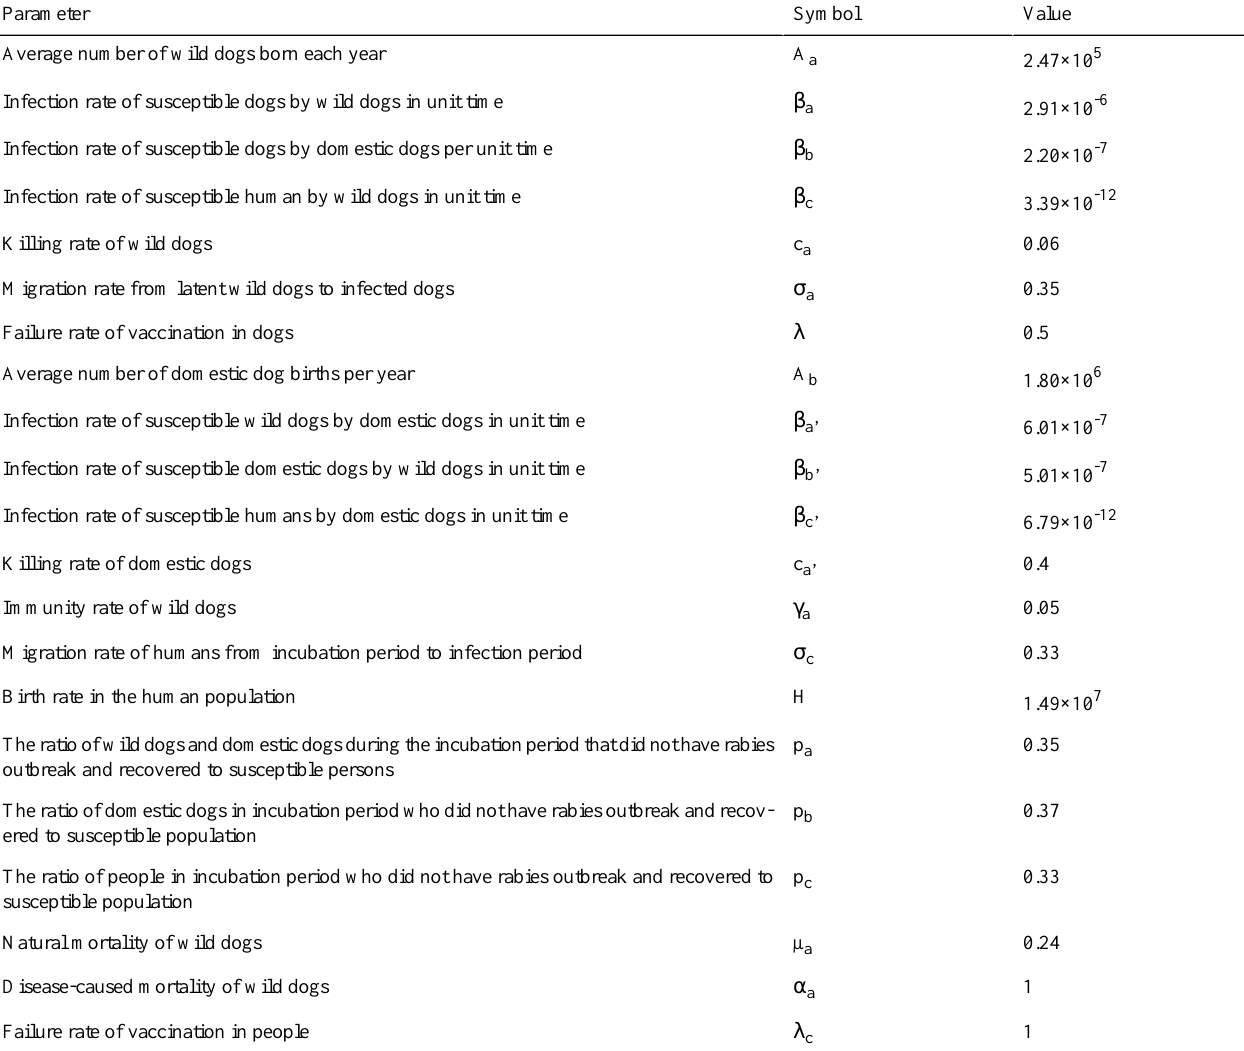
Table 1. Data list of parameters used for Equations